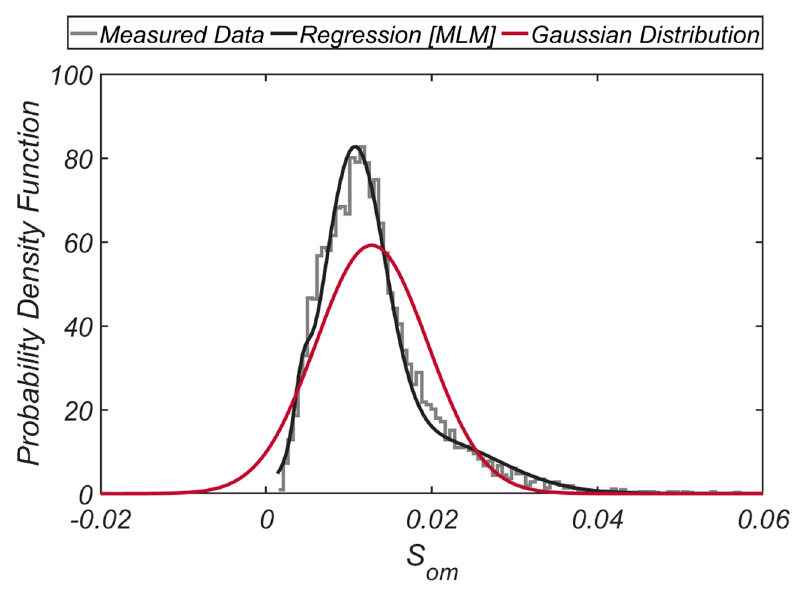
S with the measured one. Figure 11. Comparison of Gaussian distribution of wave slope S om with the measured